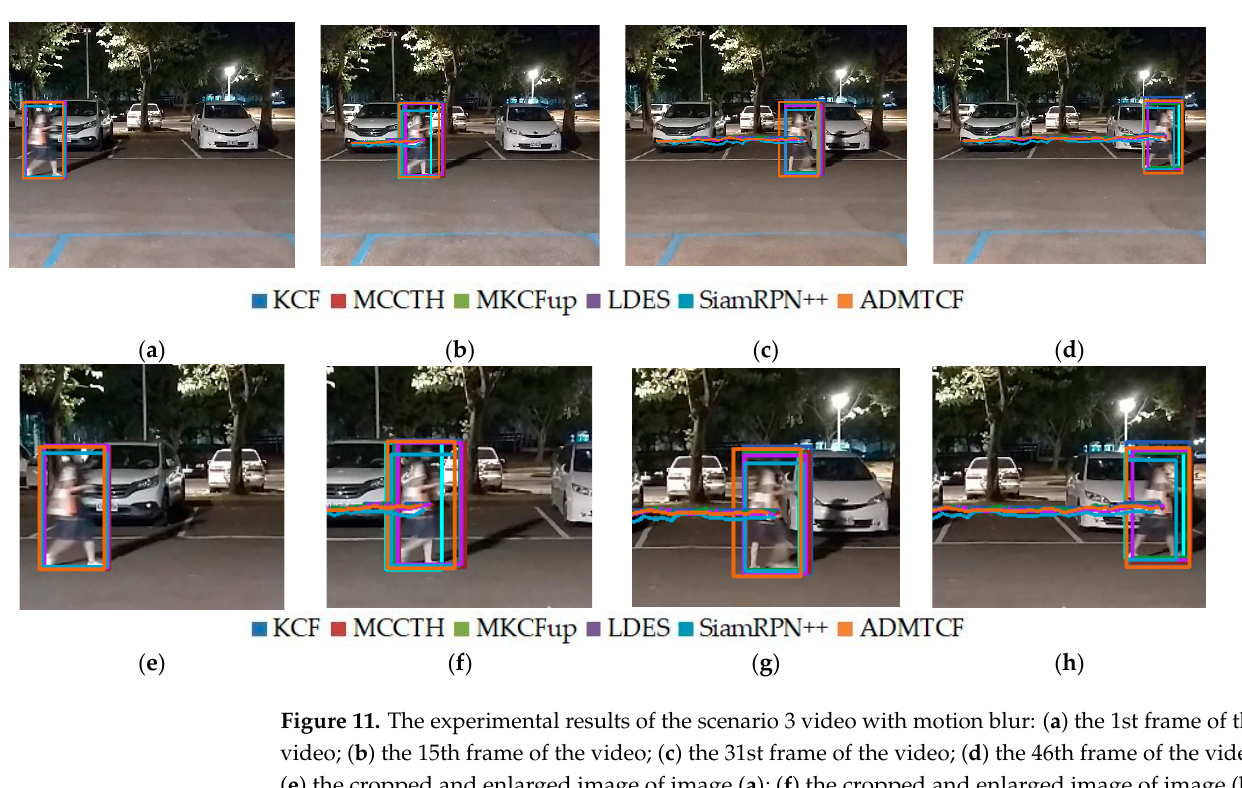
Figure 10. The experimental results of the scenario 2 video with deformation: ( a ) the 15th frame of the video; ( b ) the 38th frame of the video; ( c ) the 49th frame of the video; ( d ) the 58th frame of the video.